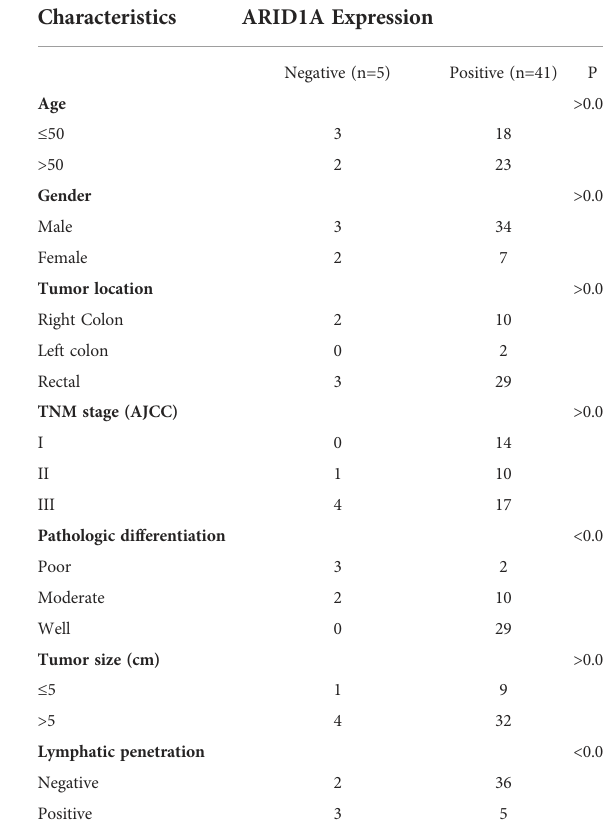
FIGURE 6 Effect of ATRi on ex vivo explants from CRC patients. (A) Example of IHC staining of ARID1A expression from clinical CRC tumor cells with and without ARID1A expression. (B) Western blot of CK20 expression from primary CRC cells; GAPDH was used as an internal control. (C) ATP-Tumor Chemosensitivity Assay for the effect of the ATR inhibitor VE822 on ex-vivo cells from CRC patients. ATP activity was measured after treatment of ex-vivo cells with concentration ranged from 0, 2.5 up to 100 nM in cells from CRC patients with (+) and without (-) ARID1A expression.